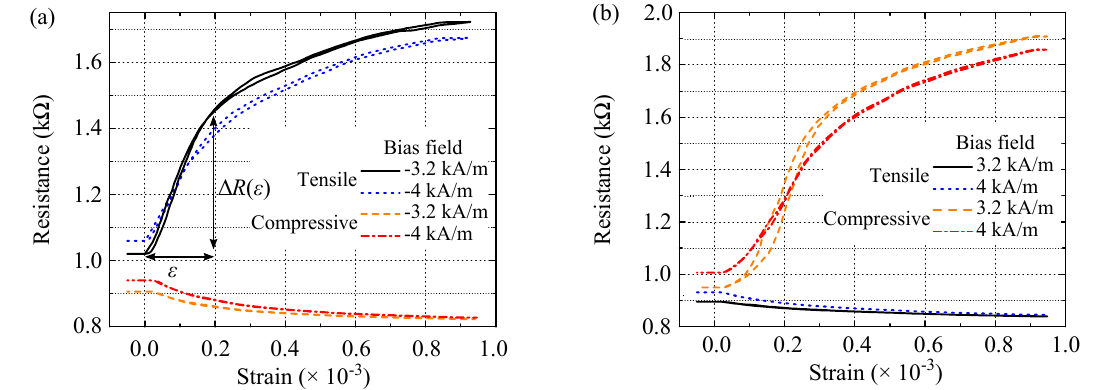
Figure 6. Strain loops of the junction measured in the presence of ( a ) negative and ( b ) positive bias fields. ∆ R ( ε ) stands for the resistance change in the strain loops, associated with the applied strain ε . Panel ( a ) is partially reproduced from [22] with permission from Elsevier.